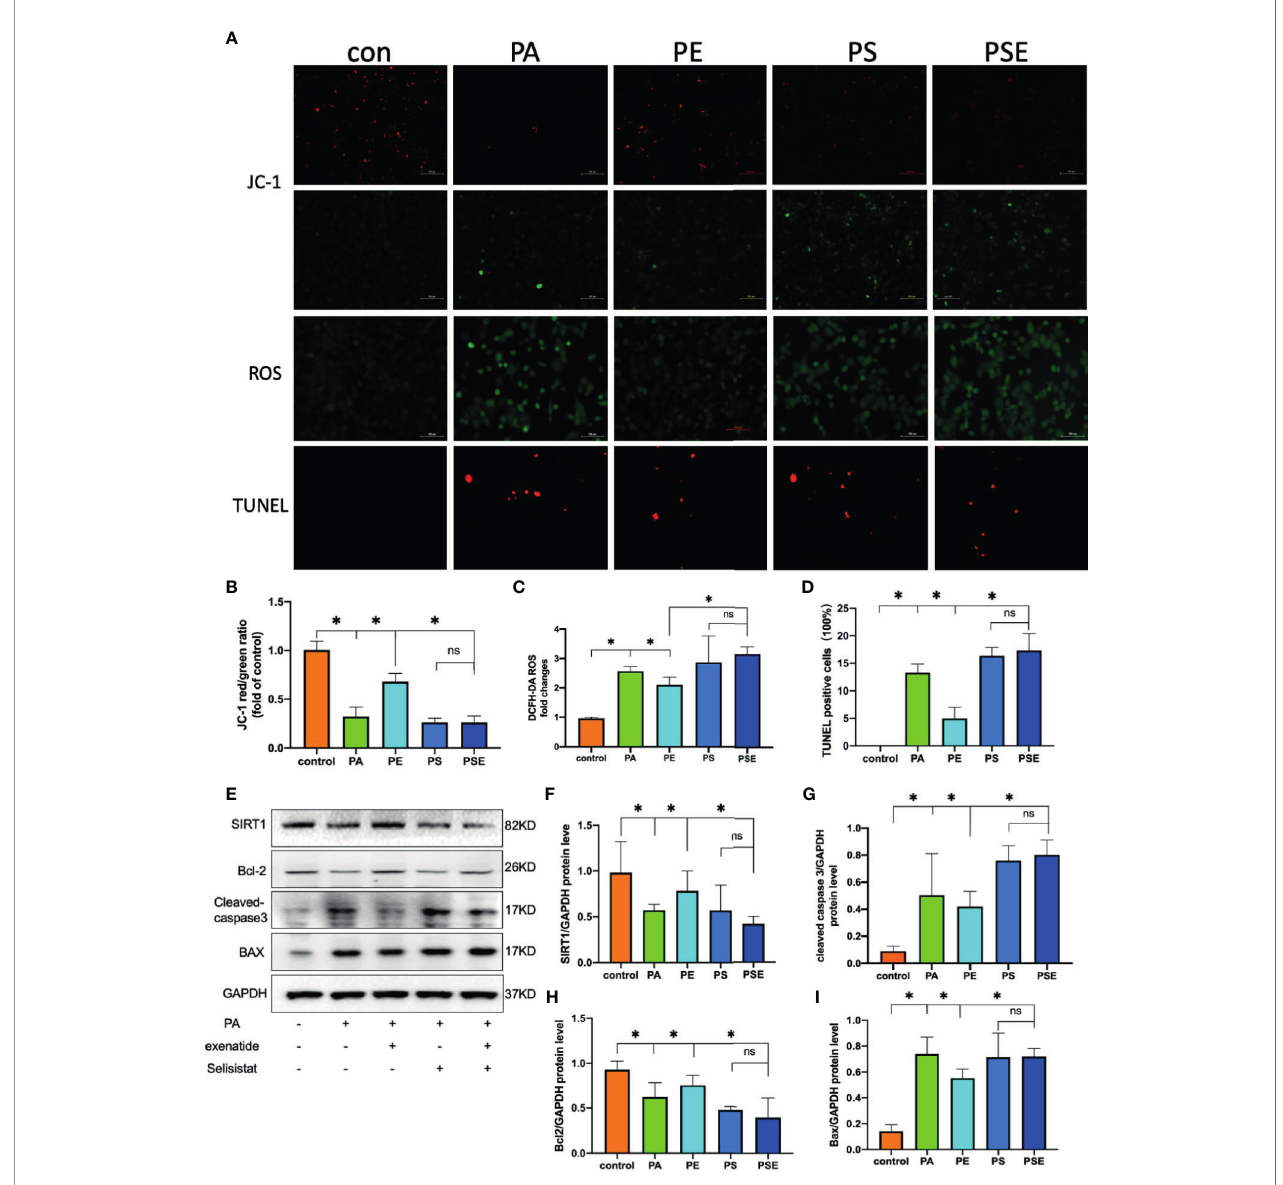
FIGURE 4 | Exenatide suppresses PA-induced apoptosis via SIRT1 restoration. HK2 cells were treated with 100 nM exenatide plus 10 µM Selisistat and incubated with PA (0.5 mM) for 24 h. (A) Intracellular mitochondrial membrane potential was examined by JC-1 staining, intracellular ROS was examined by DCFH-DA staining and apoptosis was examined by TUNEL staining, all of which were detected by fl uorescence microscopy (original image magni fi cation: ×200, bars=100 m m). (B – D) Calculated mean fl uorescence intensity of JC-1 and DCFH-DA staining and mean percentages of TUNEL staining-positive cells. (E) Western blots of SIRT1, cleaved caspase-3, Bcl-2 and Bax in cell lysates. (F – I) Relative protein expression of SIRT1, cleaved caspase-3, Bcl-2 and Bax. GAPDH was used as a control for protein loading. CON, control; PA, palmitate; PE, treat with PA and exenatide (100 nM); PS, treat with PA and Selisistat (10 µM); PSE, treat with PA, exenatide (100 nM) and Selisistat (10 µM). Data are presented as the mean ± SD (n=3). *P < 0.01 versus PA group. NS no statistical difference between